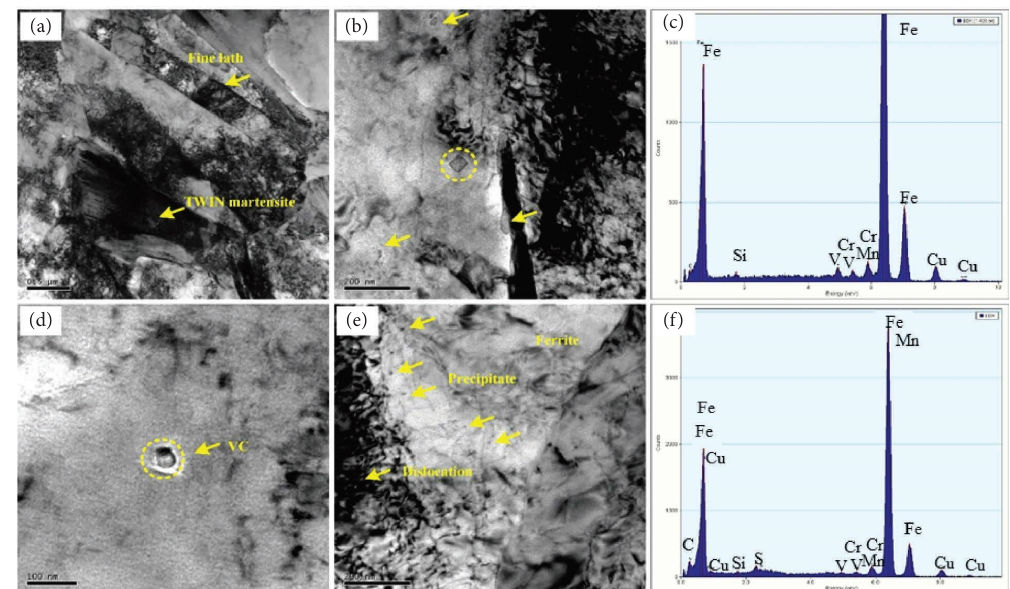
Figure 5: TEM micrographs of experimental steels: (a) morphology of granular bainite in steel A as coiling temperature is 570 ° C; (b) morphology of precipitates in steel A as coiling temperature is 570 ° C; (c) chemical composition of precipitates in steel A as coiling temperature is 570 ° C; (d) fne VC precipitate in steel A as coiling temperature is 570 ° C; (e) fne precipitates on ferrite in steel A as coiling temperature is 570 ° C; and (f) chemical composition of precipitates in steel B as coiling temperature is 540 ° C.